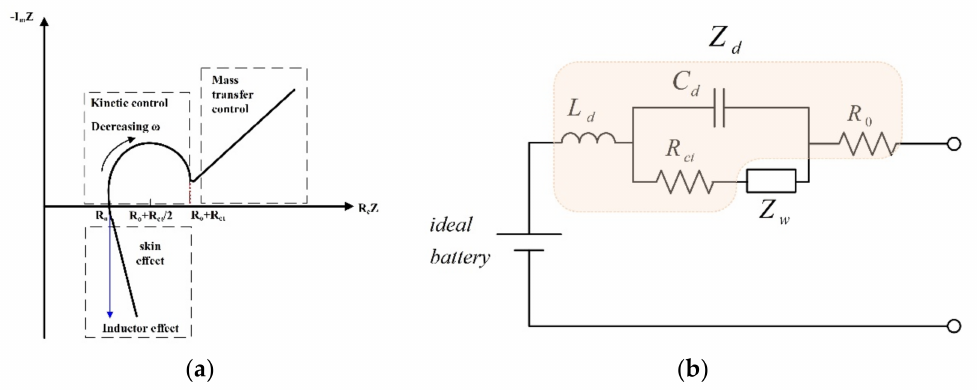
Figure 1. Nyquist plot and equivalent model of a Li-ion battery: ( a ) Nyquist plot; ( b ) an equivalent circuit model.